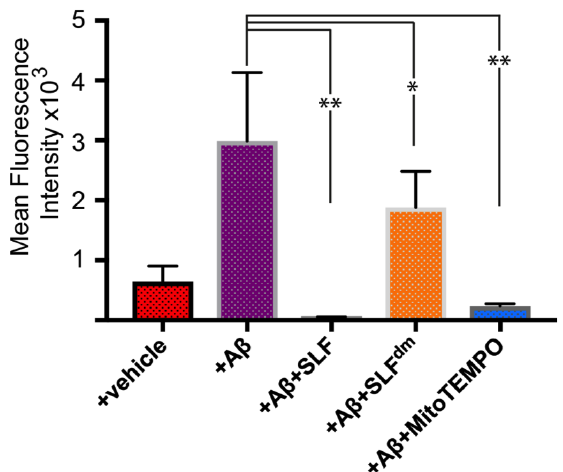
Figure 6. Quantification of mean fluorescence intensity signal from Aβ-induced ROS signal (see Figure 5) in N2a neuronal cells treated with 1 μM exogenous Aβ. The effect of SLF, SLF dm , and MitoTEMPO co-addition on the Aβ-induced ROS signal of Aβ-treated N2a cells is given by the green, orange, and blue bars, respectively, and is compared to the +Aβ group. Statistical analysis of fluorescence intensity by one-way ANOVA gives * p < 0.01, ** p < 0.001, n = 3. Error bars represent the standard error as described in the Methods section.